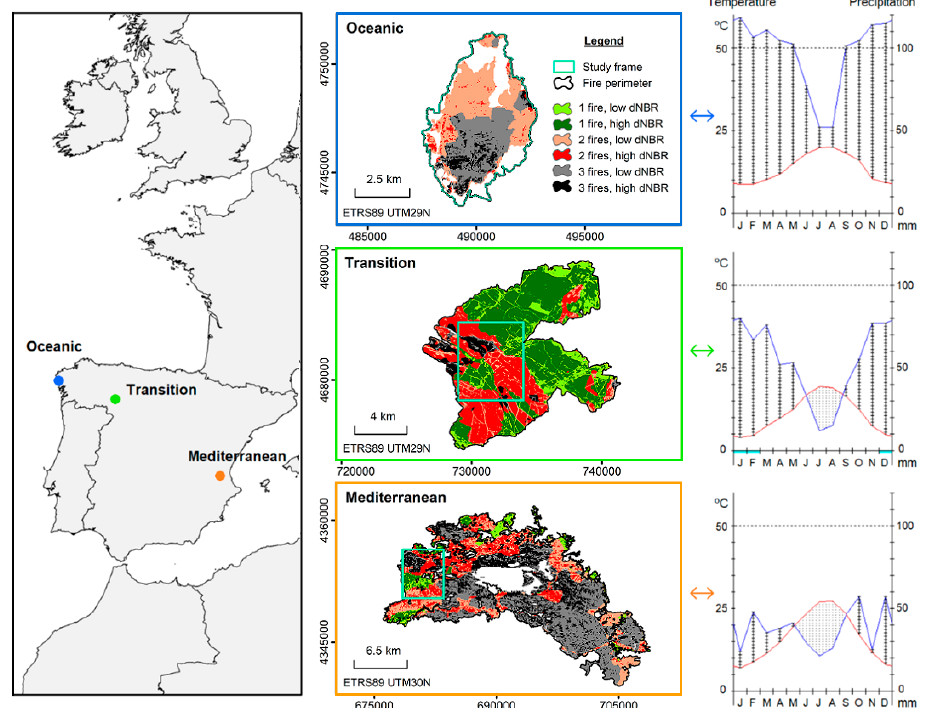
Figure 1. Location of the study sites in the Iberian Peninsula (panel on the left) and perimeters of the last wildfire in each study site with the different fire frequencies of 1, 2, and 3 fires and severities of the last wildfire of low and high differenced Normalized Burn Ratio (dNBR), using 0.55 as the threshold (panel in the centre). Panels on the right show the climate diagrams of the closest meteorological stations for a period ≥ 13 years [46]. Maps based on [47].